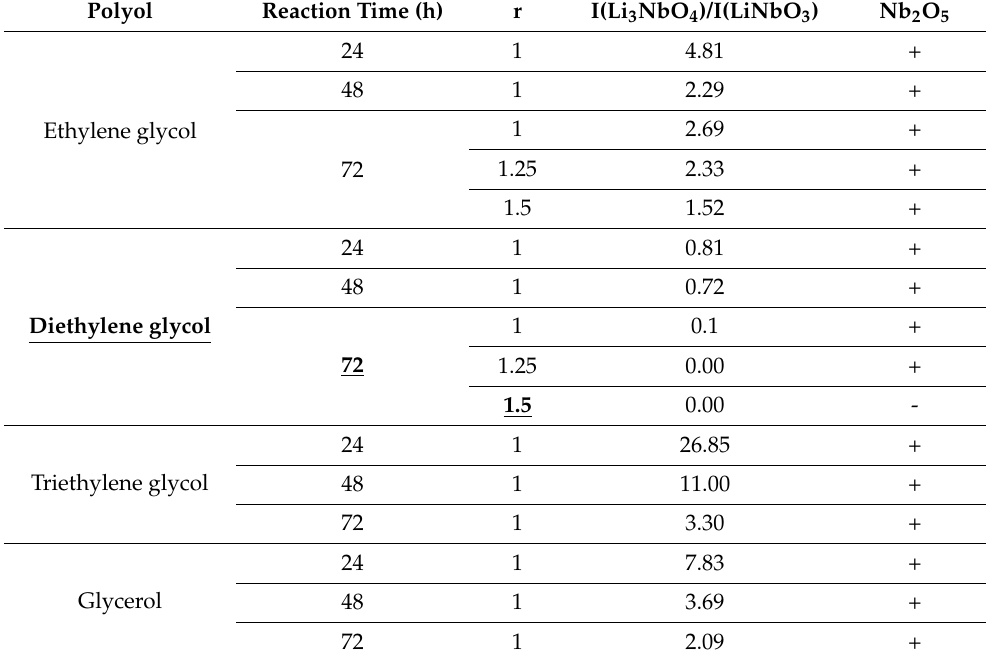
Table 1. The parameters of synthesis (polyol used, reaction time and r ) and the intensity ratio of selected diffraction peaks of Li 3 NbO 4 and LiNbO 3 phases. The presence/absence of observable amount of remnant Nb 2 O 5 is noted by +/ − sign. With the optimized reaction parameters (marked by bold and underlined), the LiNbO 3 phase could only be detected. Polyol Reaction Time (h) r I(Li 3 NbO 4 )/I(LiNbO 3